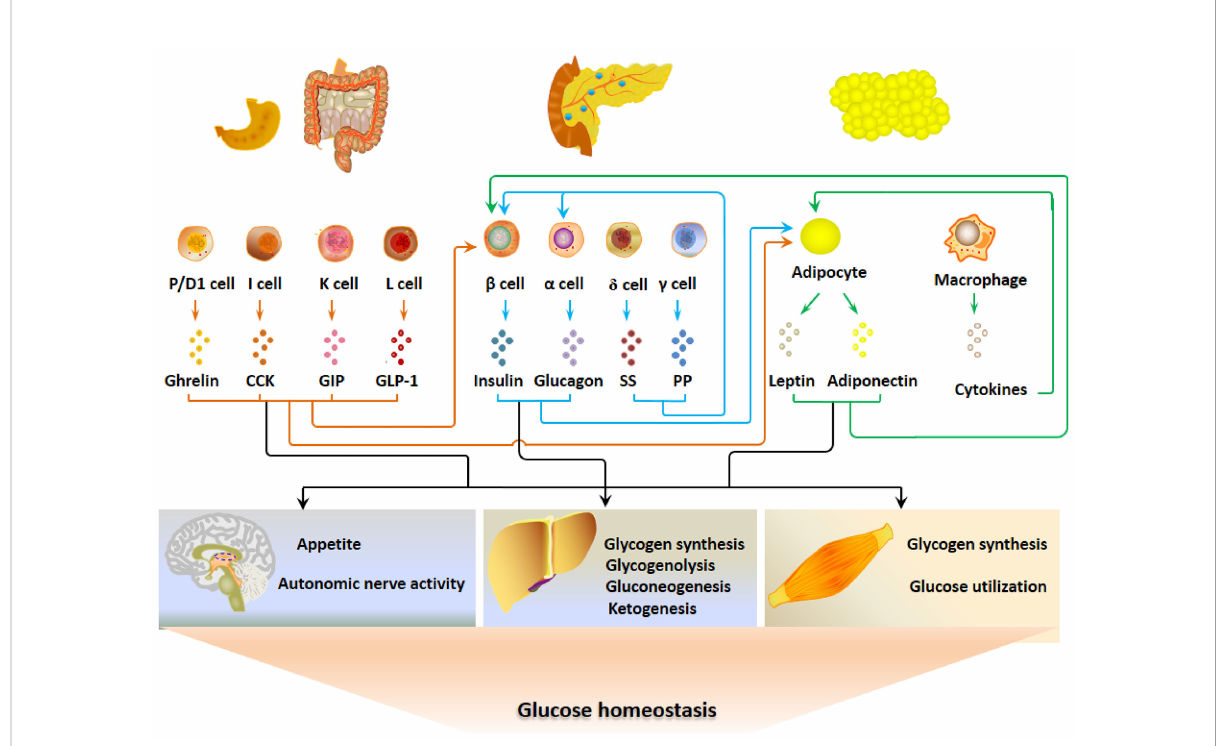
FIGURE 1 The gastrointestinal-pancreatic-adipose (G-P-A) interactions and hormonal regulation of glucose metabolism. When the blood glucose levels elevate after ingestion, insulin and certain GI hormones increase and act on the main target organs that include liver, skeletal muscle and central nervous system to lower blood glucose. Adipokines regulate glucose metabolism by altering appetite, insulin secretion, insulin sensitivity and glucose utilization, which may be a long-term mechanism for glucose